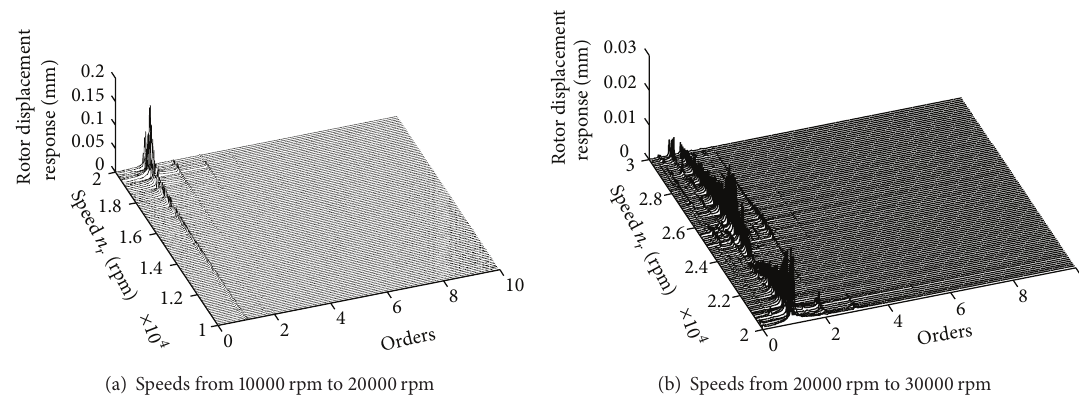
Figure 8: Cascade plot of the rotor displacement response at different speeds.